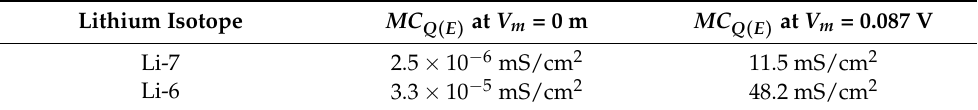
Table 13. The table shows that extracellular lithium isotopes can have a range of quantum membrane conductance from the value at V m = 0 V to the value at V m = 0.087 V according to the setting values in graph (c) of Figure